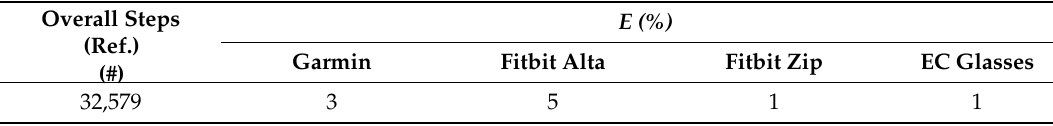
Table 2. Error ( E) of every investigated step counter.